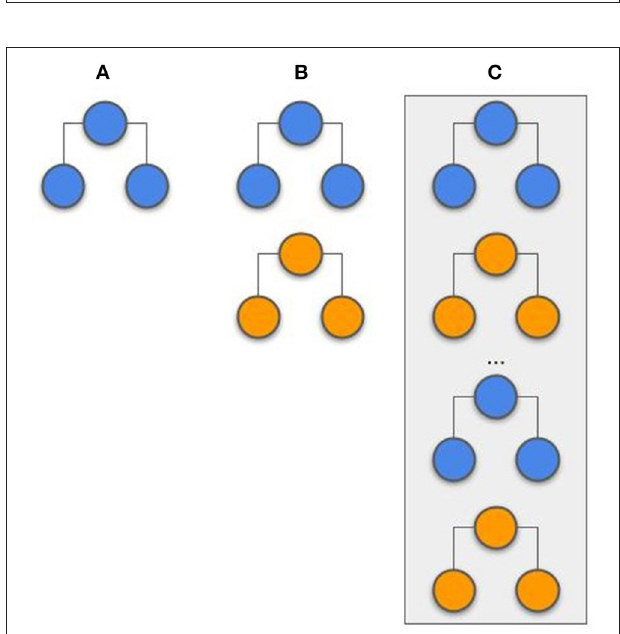
FIGURE 2 | Example of a tree-based model (random forest) that is created by two different centers (represented by different colors). (A) A predefined number of trees is initially created by the first center. (B) The second center adds new trees to the forest, without modifying the previous trees. (C) The random forest training process is complete, with the same number of trees from each center.